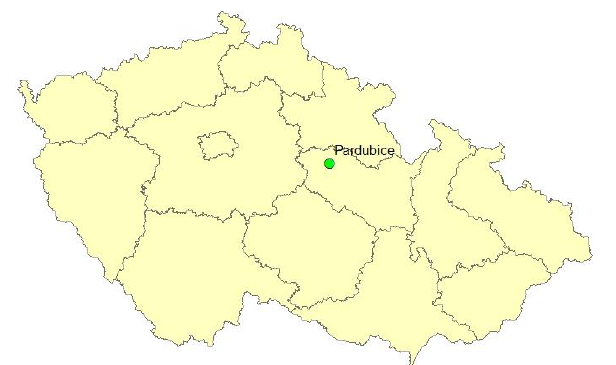
Fig. 3: Placement of the city of Pardubice in the Czech Republic, source: authors